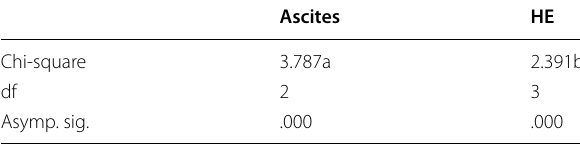
Table 4 Qualitative variables in predicting 3-month